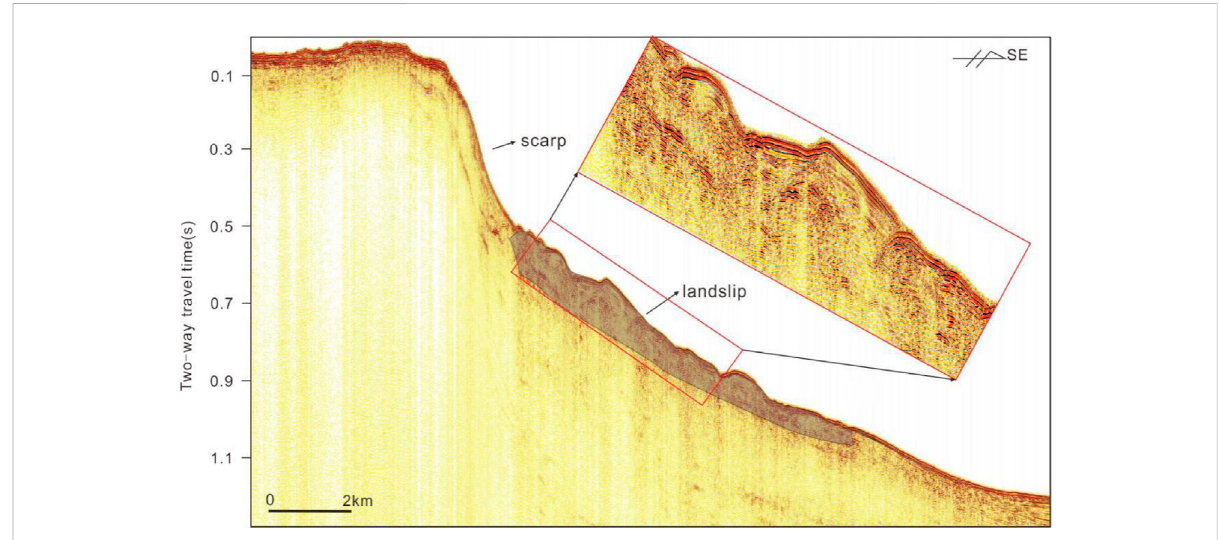
FIGURE 5 The re fl ection characteristics of landslides on the platform slope are displayed on a single